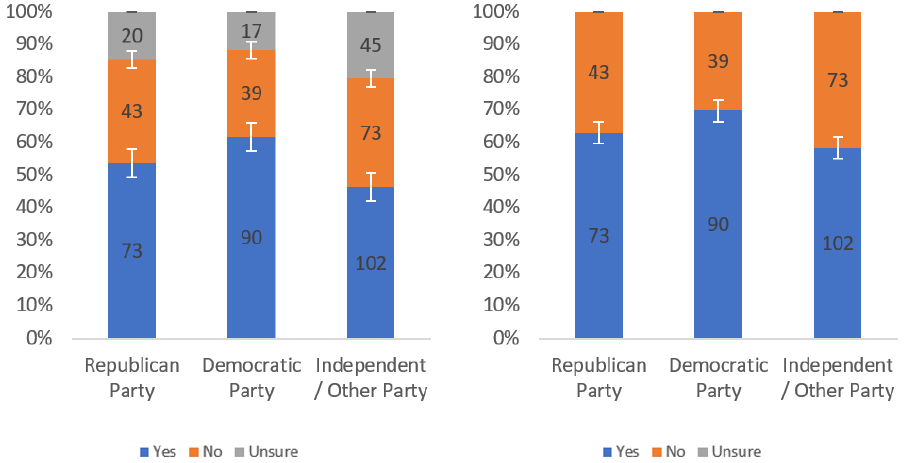
Figure A2. Responses regarding label helpfulness by party affiliation including ( left ) and excluding ( right ) unsure responses.